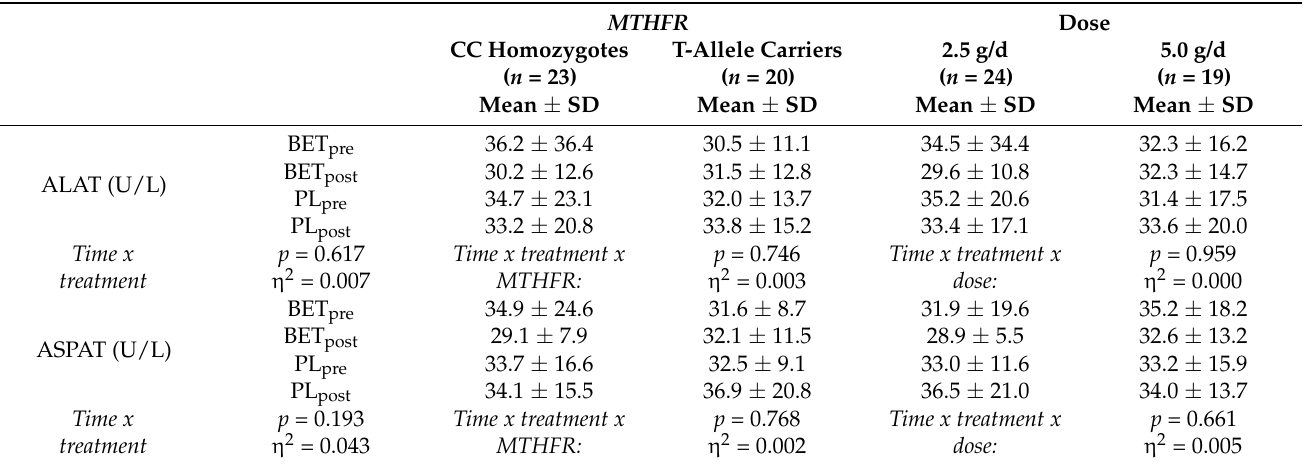
Table 6. The effect of betaine supplementation on liver enzymes and its relation to MTHFR geno- type and BET dose.